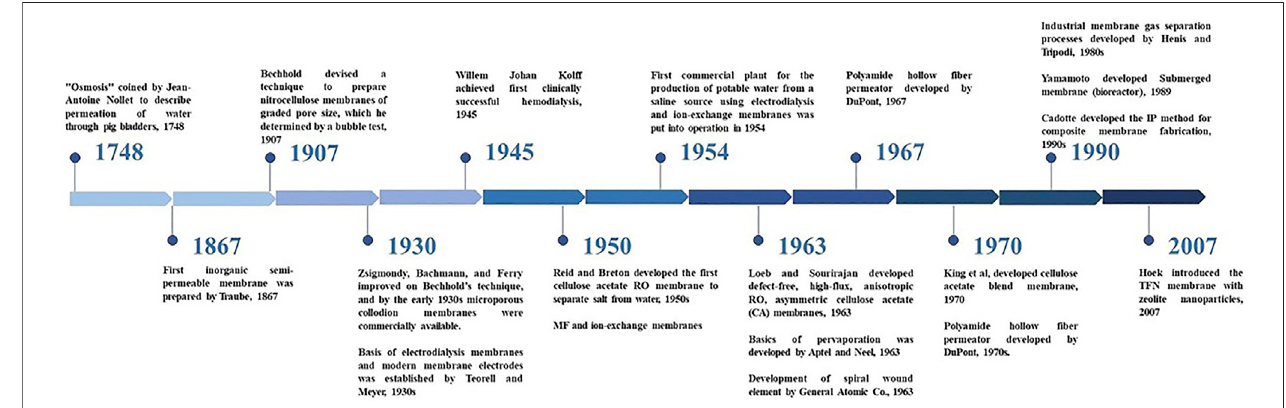
FIGURE 1 | History of the development of membrane